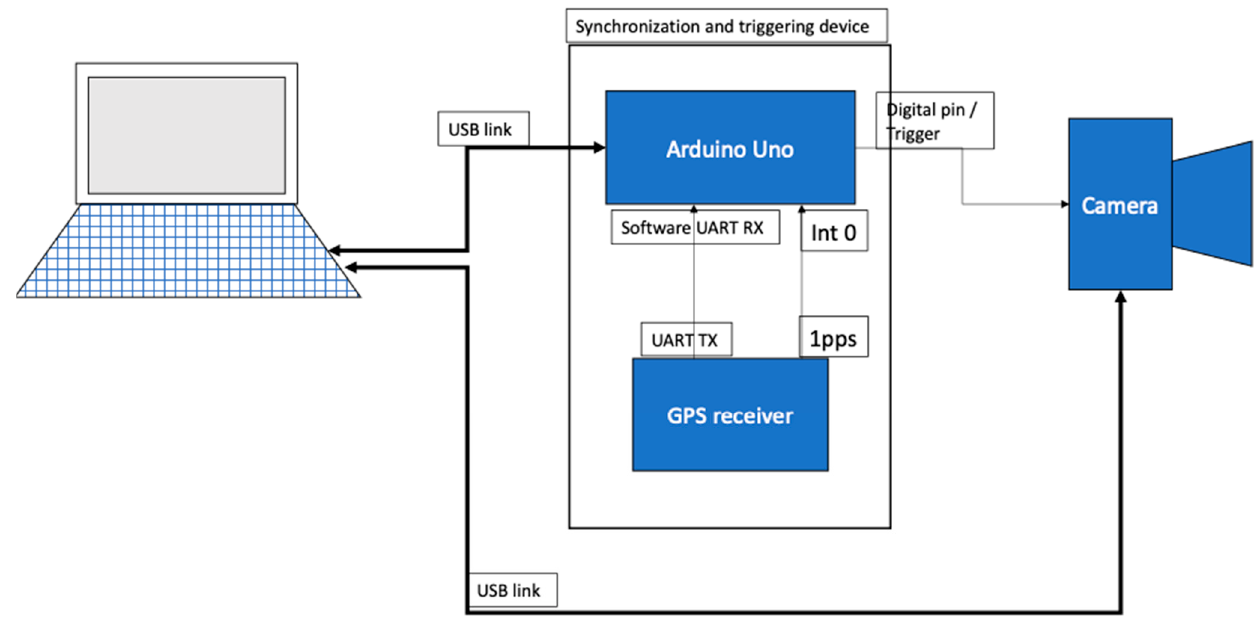
Figure 1. The hardware architecture of the image acquisition and processing system.